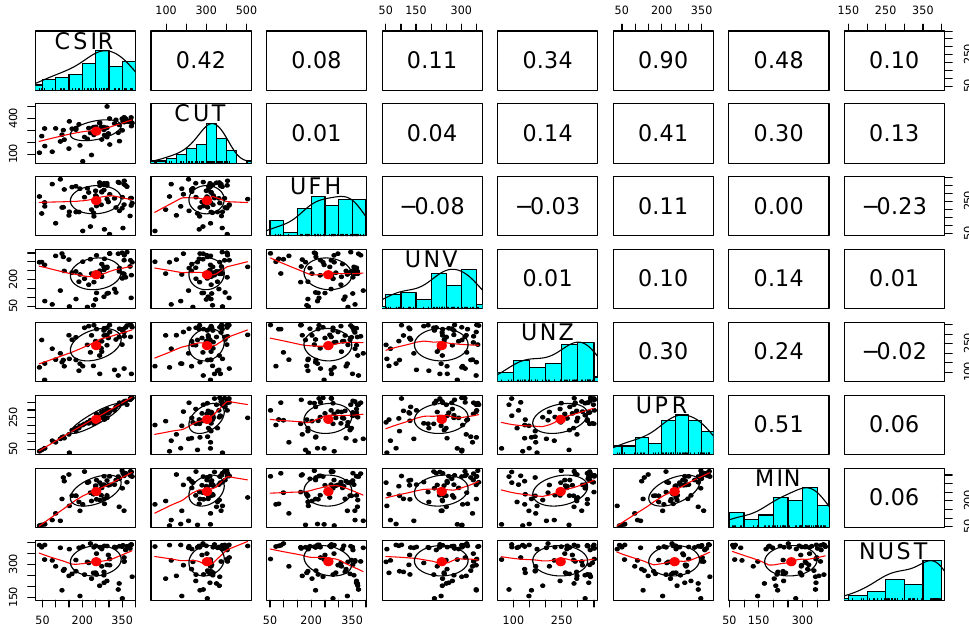
Figure 6. Histograms (diagonal), pairwise scatter plots ( bottom left ), and pairwise Kendall’s rank correlation coefficients ( top right ) of GHI for all the eight radiometric